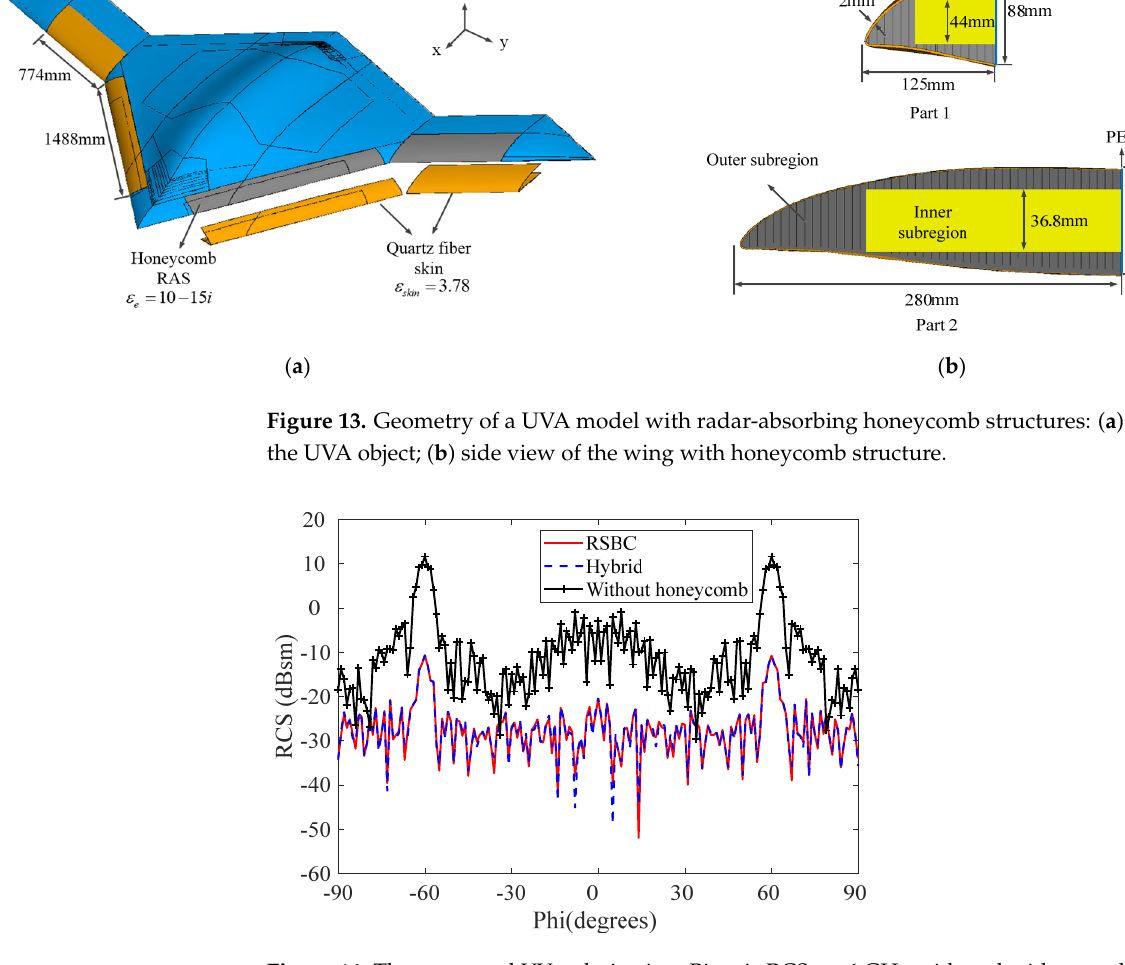
Figure 14. The computed VV polarization. Bistatic RCSs at 6 GHz with and without radar-absorbing honeycomb structures.